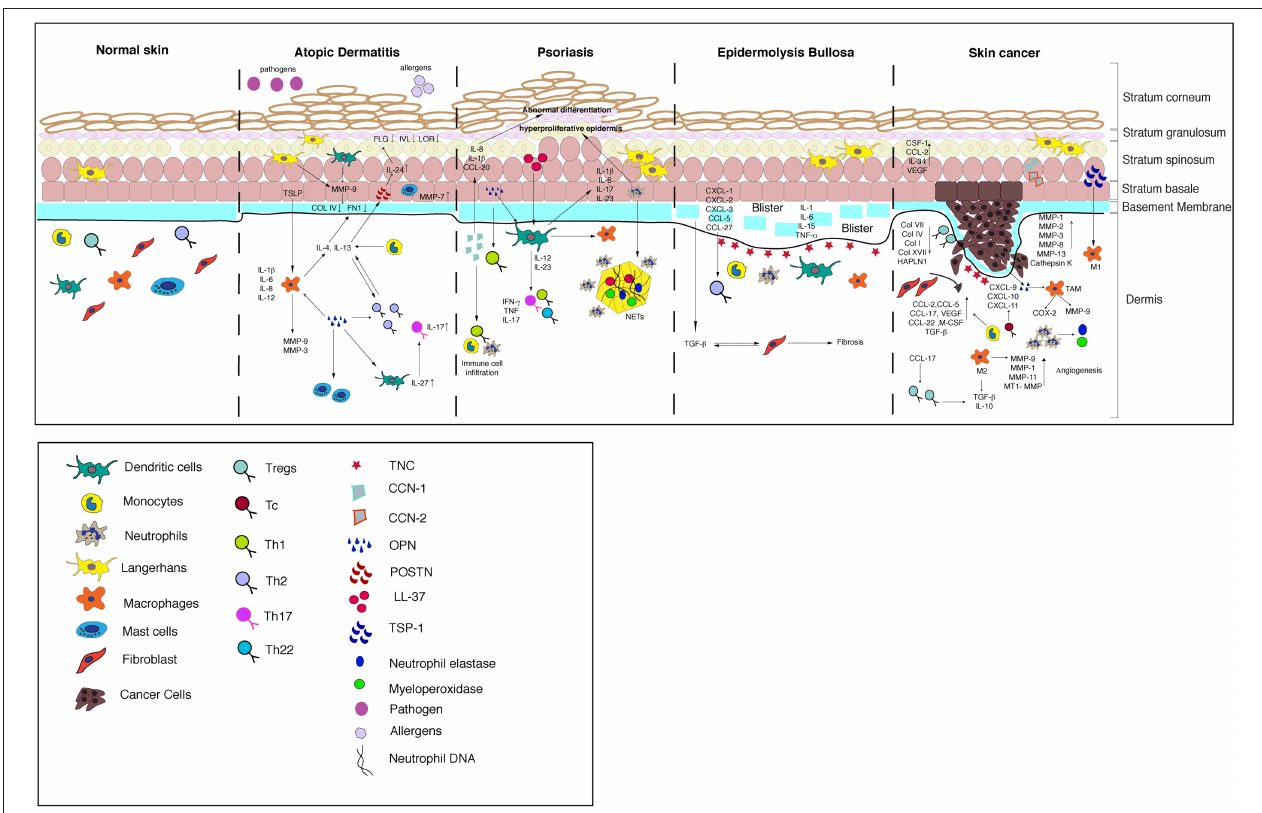
FIGURE 3 | A model summarizing the crosstalk between the ECM and immune cells in the skin diseases discussed in this